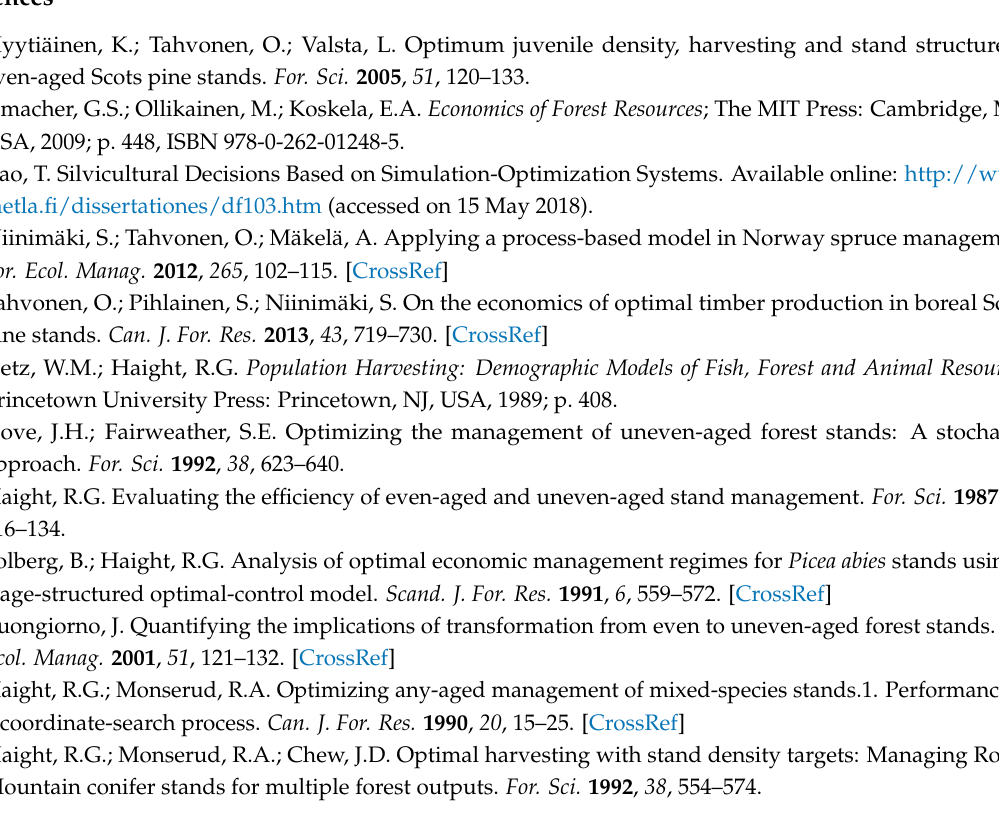
Figure A1. An example of the diameter distributions in the 20-year-old Scots pine stands on fresh mesic heath site ( Myrtillus type, MT). The distributions represented dense ( N 3500 ha − 1 ), average ( N 2276 ha − 1 ), and sparse ( N 1600 ha − 1 ) stands, where the expected d gM was 11.3 cm and G 14.4 m 2 ha − 1 . Tree heights of 10- ( (cid:7) ) and 40- ( ○ ) tree samples taken from the average density distribution are indicated with the secondary axis (on the right-hand side).